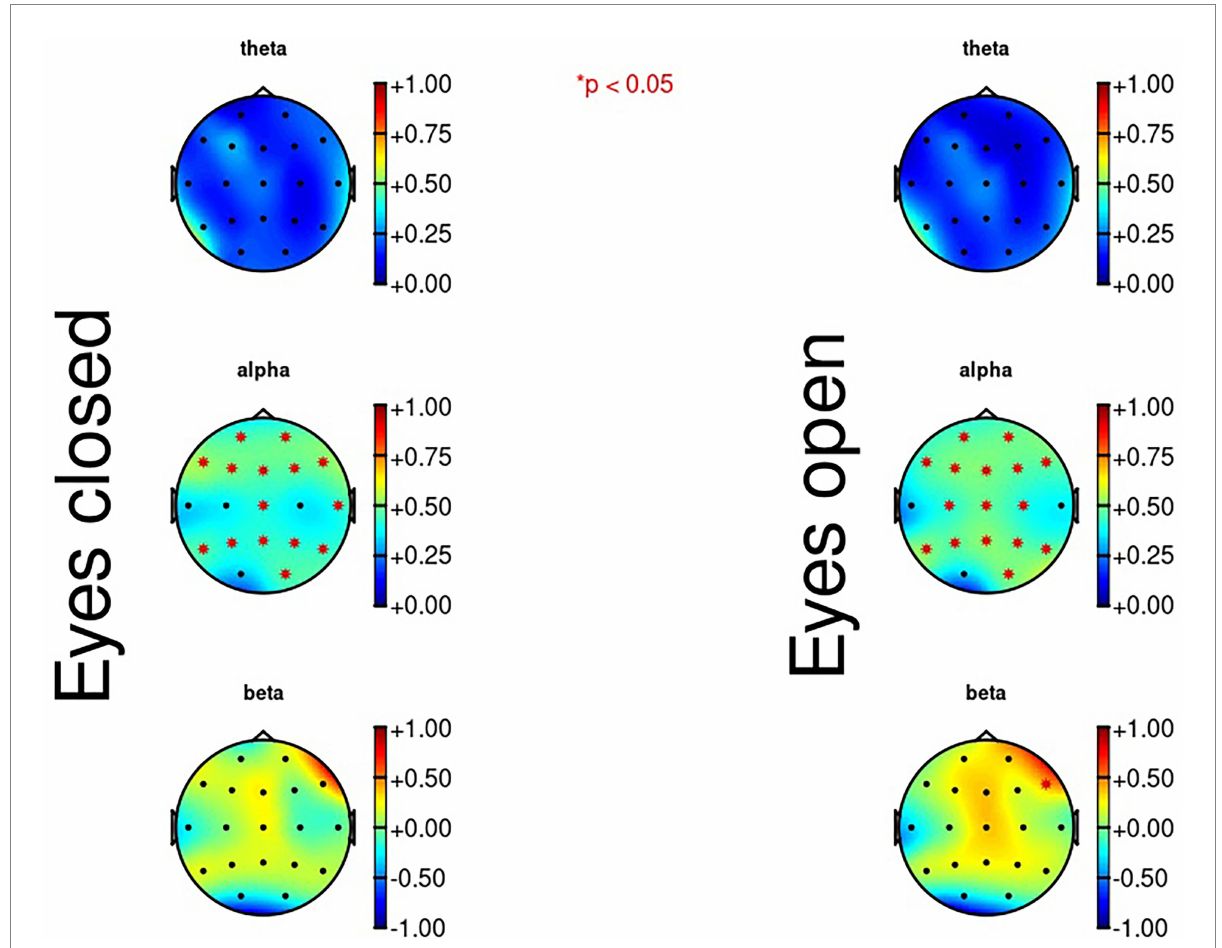
FIGURE 7 Correlation maps for the EEG resting State and the subscale “women are